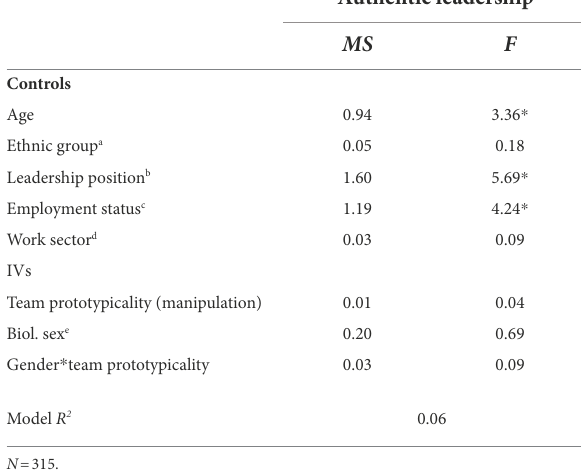
TABLE 1 Study 1: Results of preliminary analyses with ANCOVA. Authentic